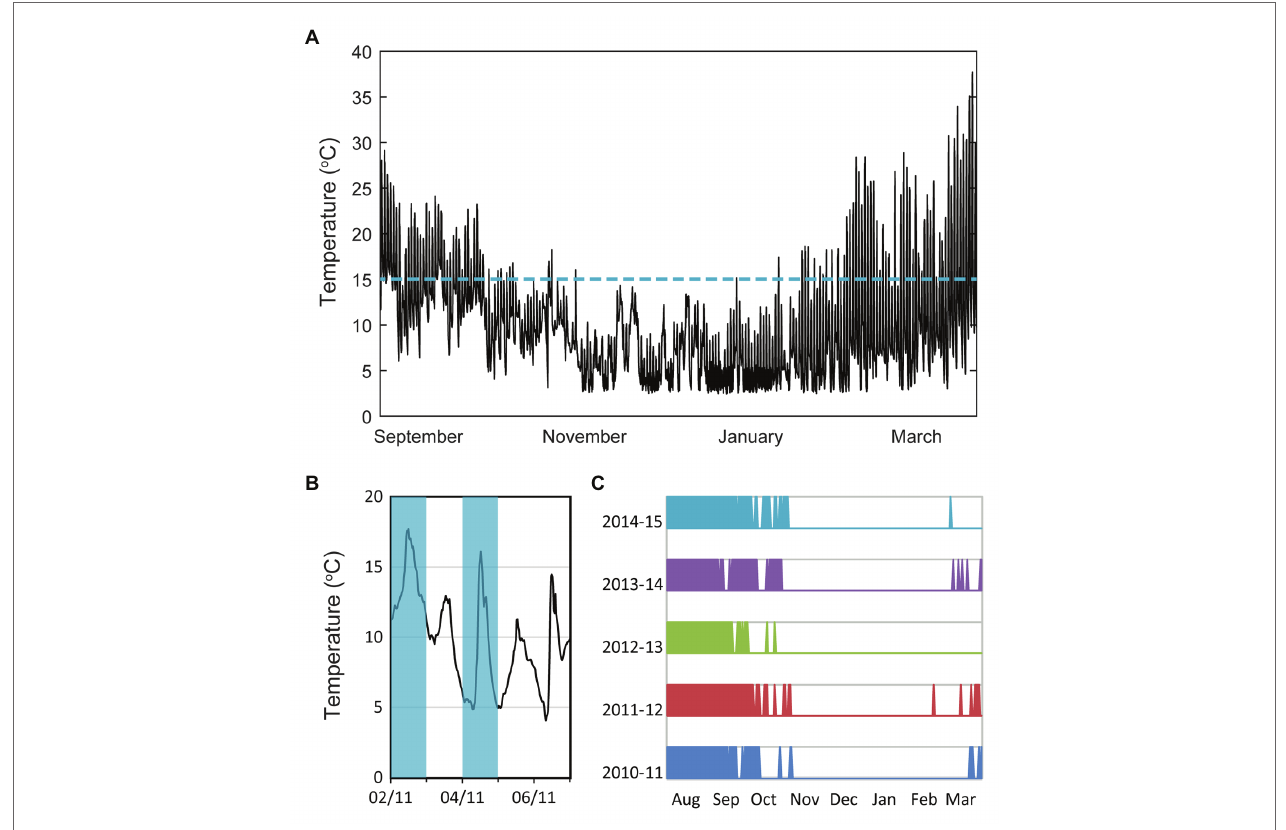
FIGURE 1 | Importance of temperature fluctuations in plant seasonal sensing. (A) Temperature profile at experimental site in Norwich, United Kingdom, measured over 200 days from September 29, 2014 (Hepworth et al., 2018). (B) Schematic of classification of days according to whether the temperature fluctuated to above 15 ° C or not, during the day. This classification is used in the next panel. (C) Data from Norwich Airport, United Kingdom for the indicated years. Information provided by the National Meteorological Library and Archive – Met Office, United Kingdom, under the Open Government License (The National Archives, n.d.). Schematic shows coloration for days where the temperature fluctuated above 15 ° C, and white for other days, as indicated in (B) . The continuous white period matches